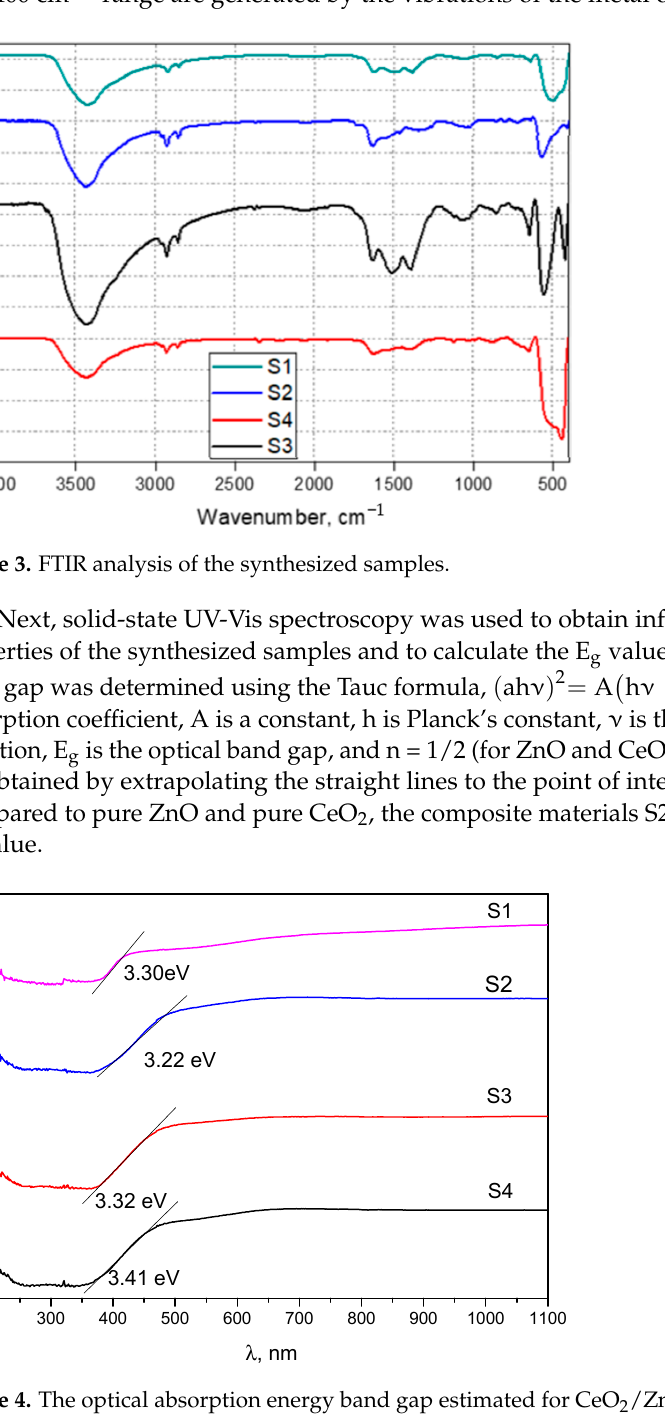
Figure 2. SEM micrographs ( left ) and EDAX pattern of the S1–S4 samples ( right ).